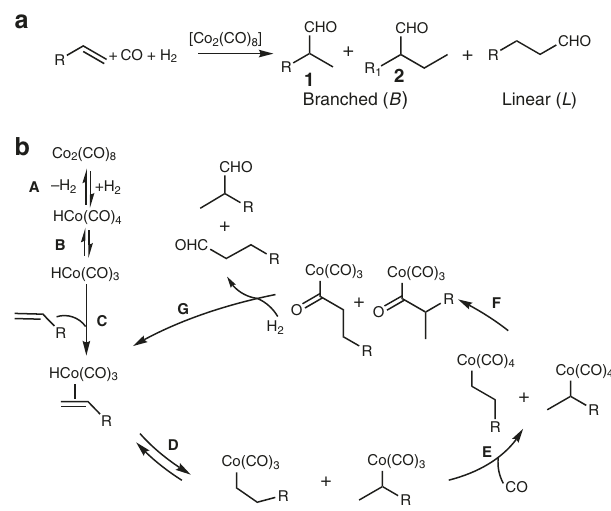
Fig. 1 Co-catalysed hydroformylation. a General scheme. For 1-hexene R = C 4 H 9 , R 1 = C 3 H 7 . b Accepted mechanism for the co-catalysed hydroformylation of ole fi